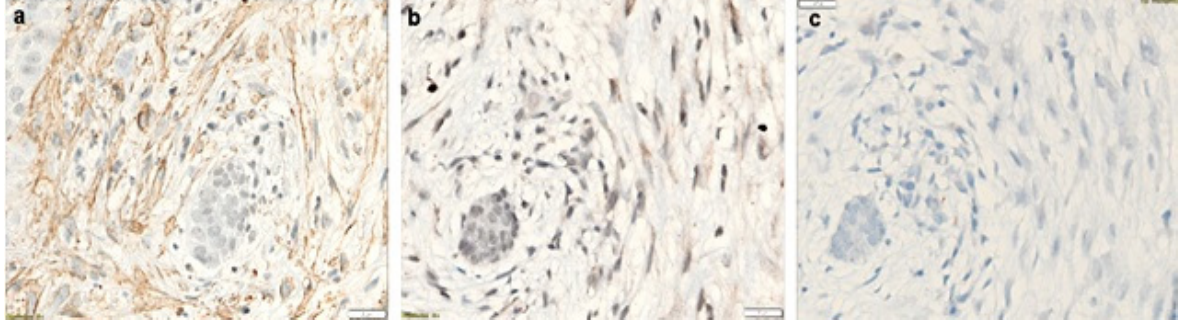
Figure 3. NBCCS-OKC (same case in Figure 2a–c), magnifications ×40. ( a ), α SMA expression, x40; ( b ), MMP-7 expression, ×40; ( c ), MMP-9 expression, ×40.